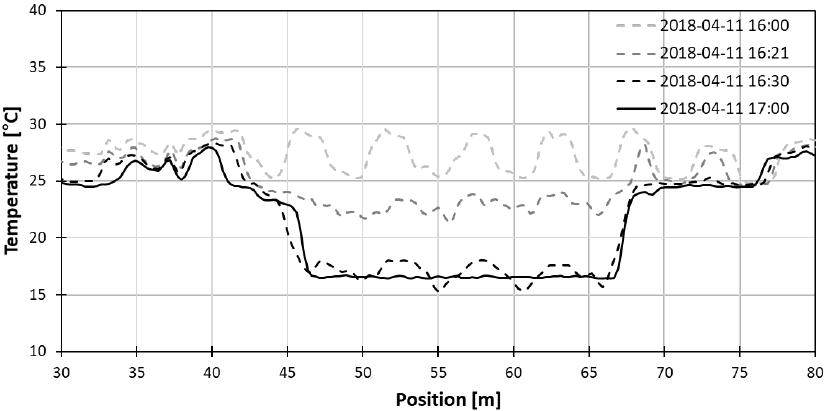
Figure 7. Temperature change with time at the fiber optic cable submerged in water.